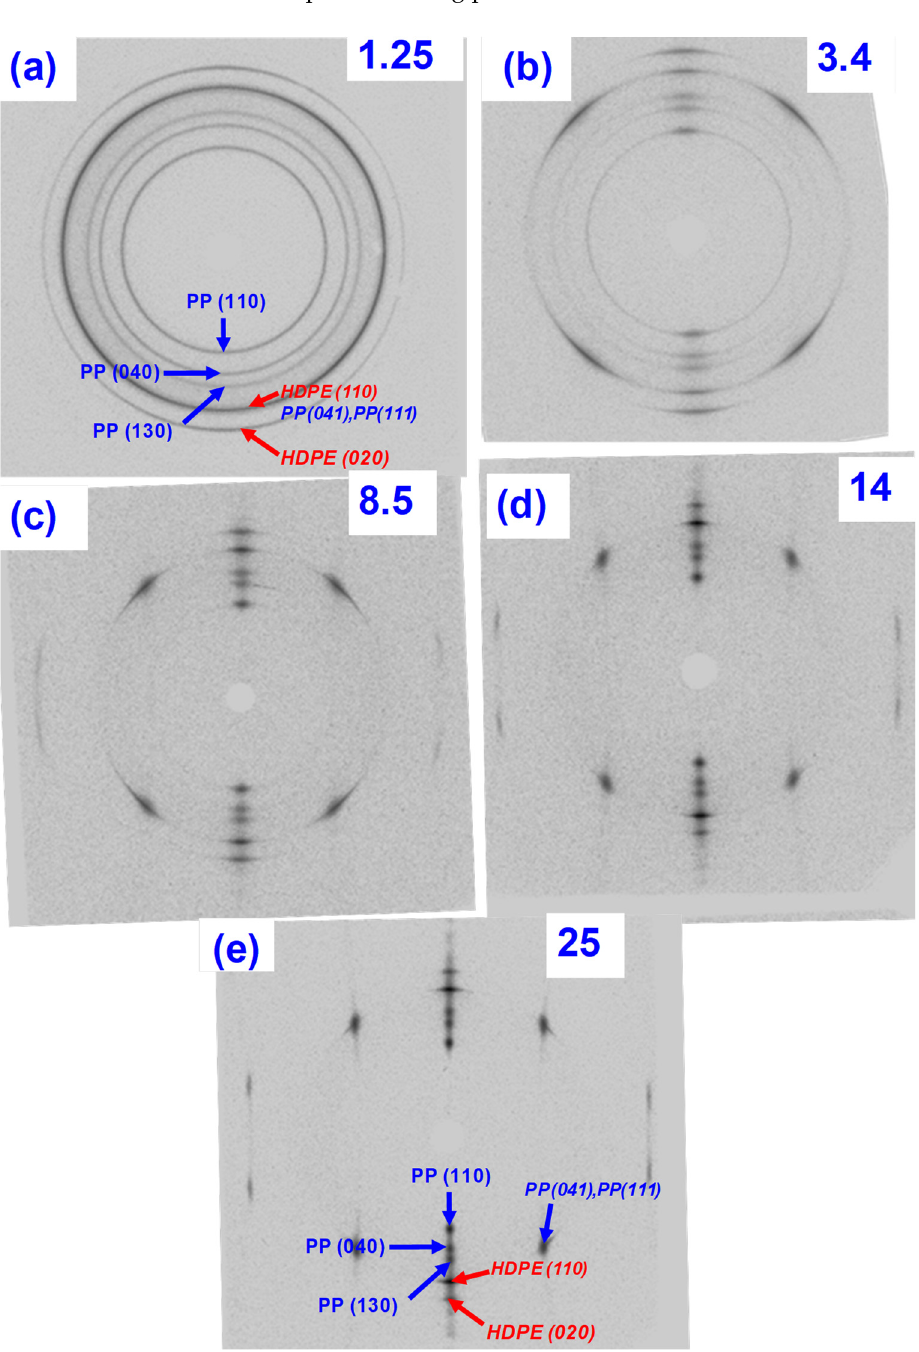
Figure 10. Wide angle X-ray diffraction pattern of oriented 50/50 PP/HDPE. Tapes at draw ratios of ( a ) 1.25; ( b ) 3.4; ( c ) 8.5; ( d ) 14; and ( e ) 25.